Question: Identify the chart type used in this figure.
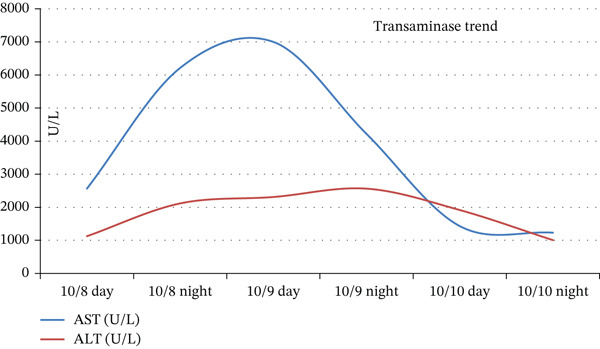
Answer: line